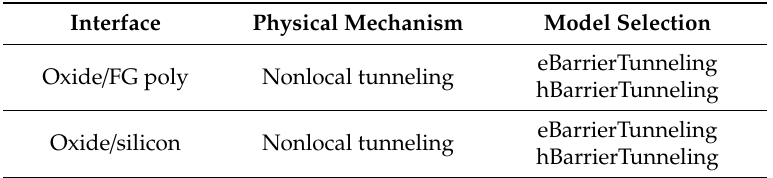
Table 1. Main physical models selection.